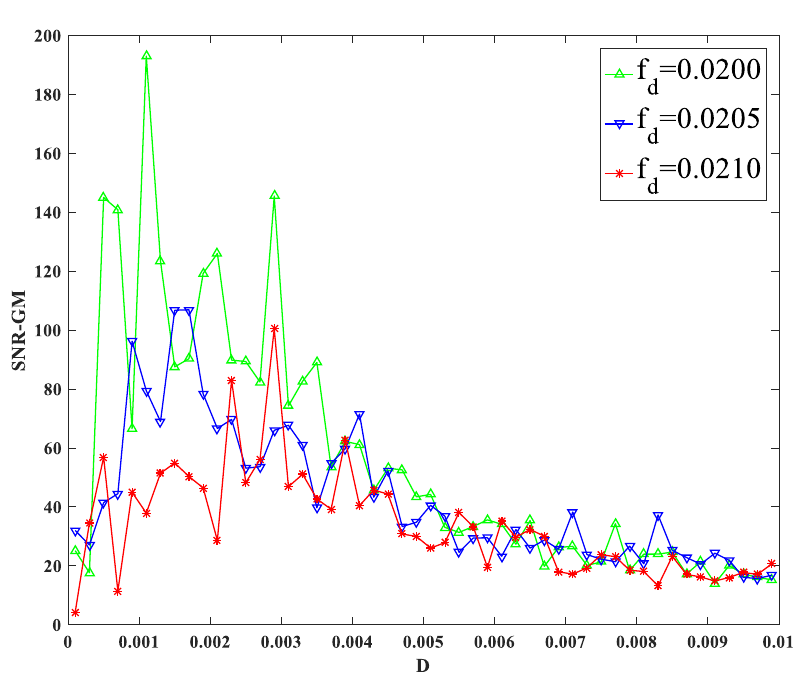
Figure 9. SNR-GM for different values of f d.